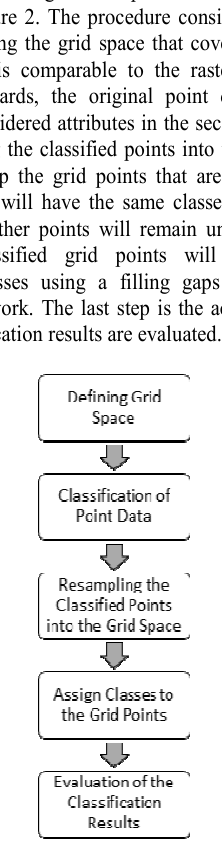
Figure 2. LiDAR Data Classification in Point Cloud